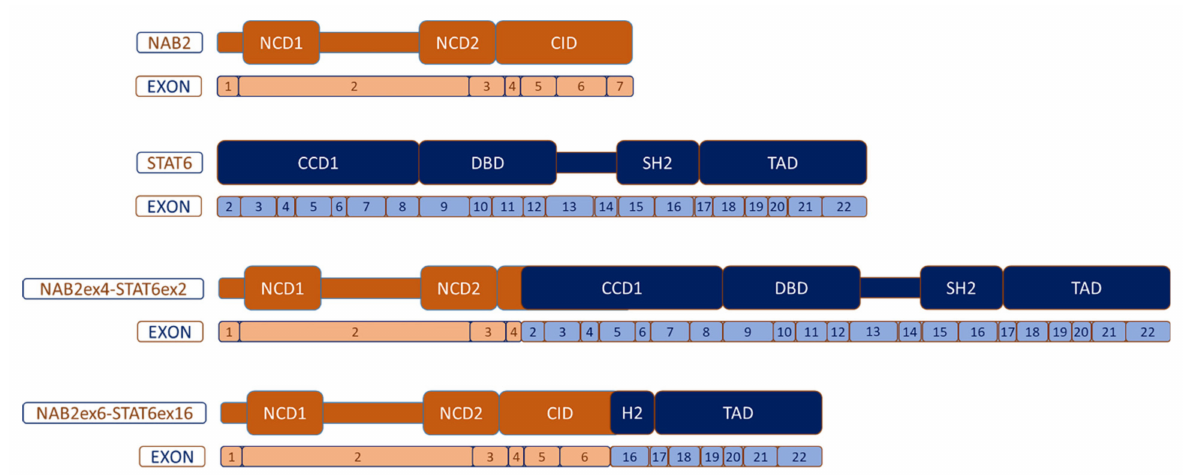
Figure 2. Most common NAB2–STAT6 fusion variants. NCD: NAB-conserved domain; CID: CHD4-interacting domain; CCD1: Coiled-coil domain 1; DBD: DNA-binding domain; SH2: Src homology 2 and TAD: transcriptional activator